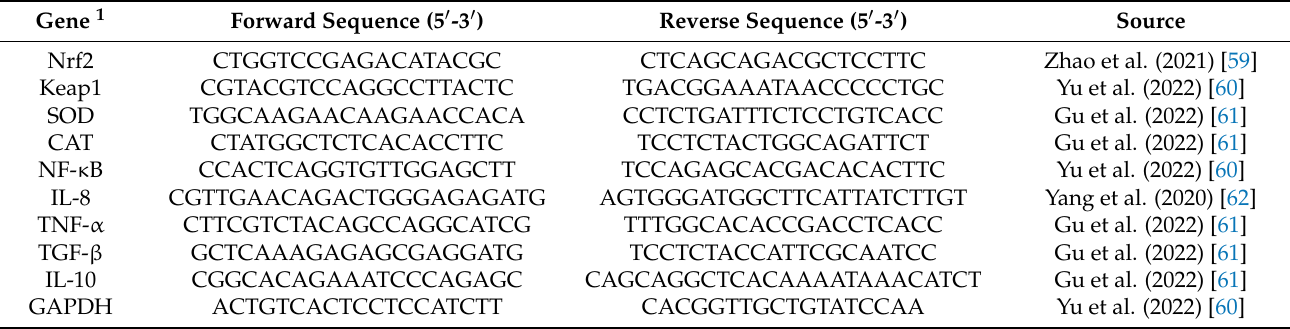
Table 6. Primer sequence for